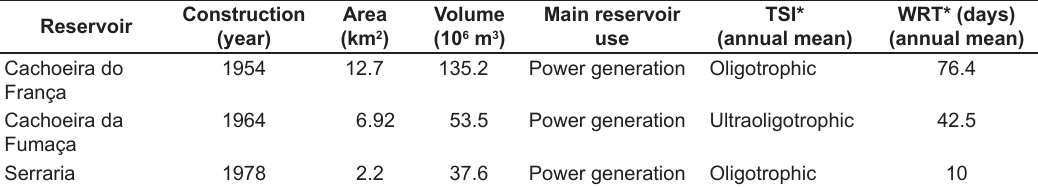
Figure 1. Study area at the Ribeira do Iguape/Southern Litoral Basin, São Paulo, SP, Brazil. Small maps show sampling sites in each reservoir. Table 1. Main limnological characteristics of the connected reservoirs Cachoeira do França, Cachoeira da Fumaça and